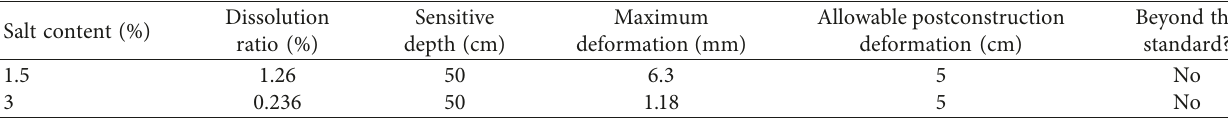
Table 6: Estimation results of the dissolved